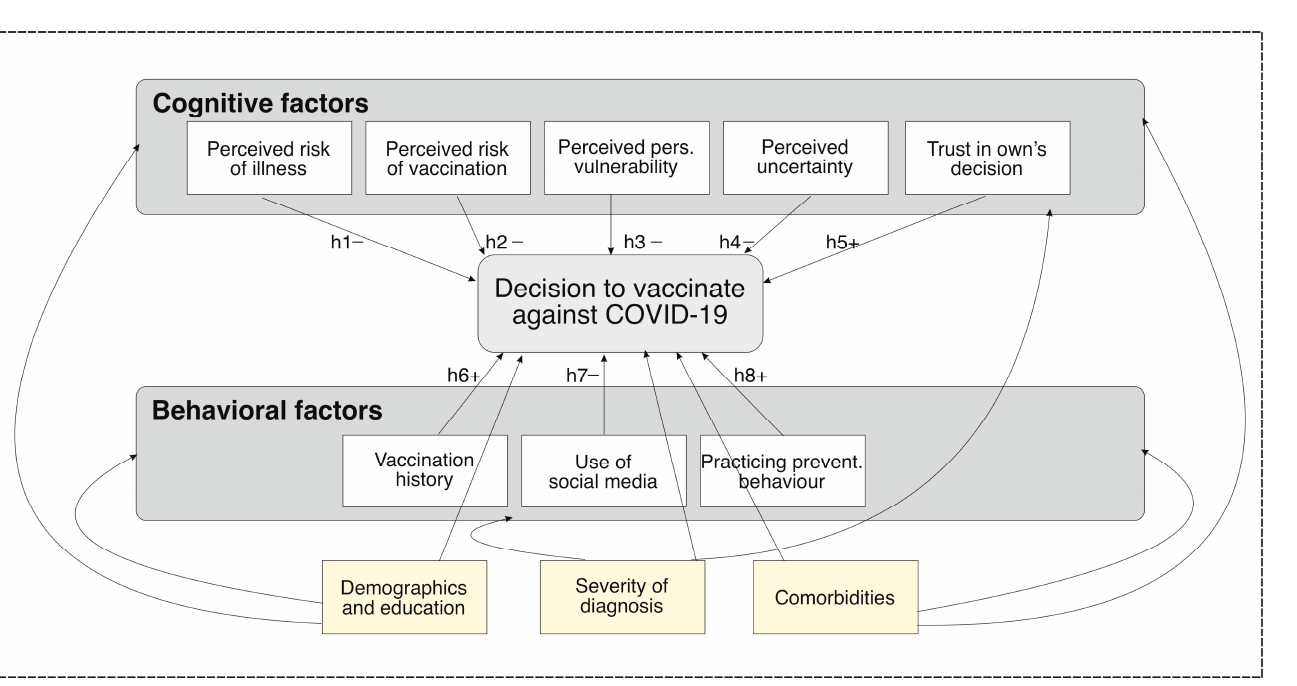
Figure 1. Schematic overview of the study’s conception. (Hypotheses are noted with